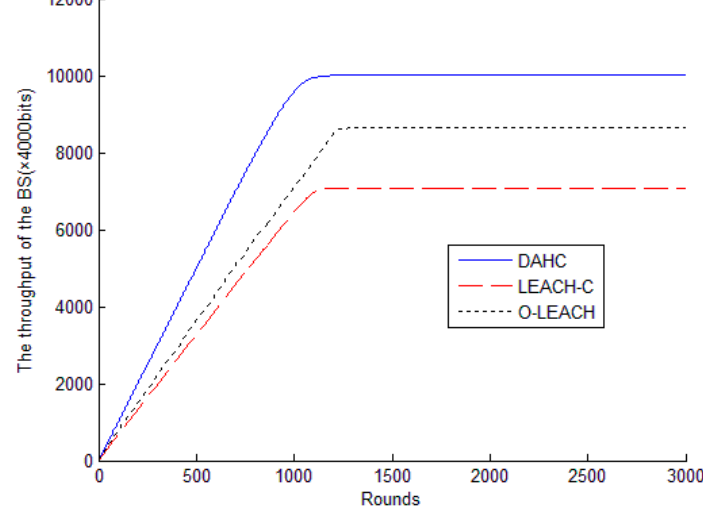
Figure 9. The throughput of the BS when it is inside.